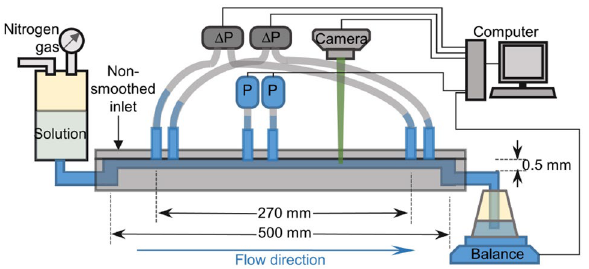
Figure 1. Schematics of the experimental setup. Six holes are used for high-resolution pressure drop and absolute pressure fluctuations measurements in three pressure ranges and in two different positions along the channel. The polymer solution is driven by compressed Nitrogen gas to the straight channel via its inlet. The fluid exiting the channel outlet is weighted instantaneously as a function of time by a computer-interfaced balance. The time-averaged fluid discharge rate is calculated from the weight difference measured by the balance as a function of time. An illuminating sheet for PIV measurement is located at the mid-plane x - z of the